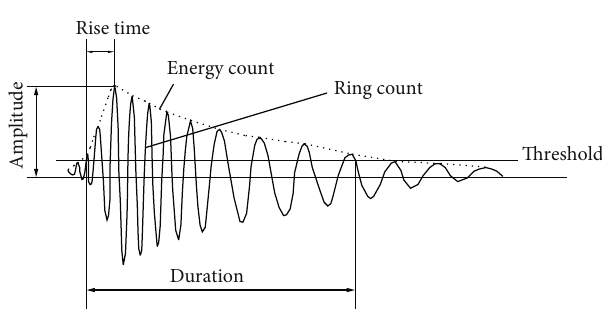
Figure 5: Characteristic parameter of burst